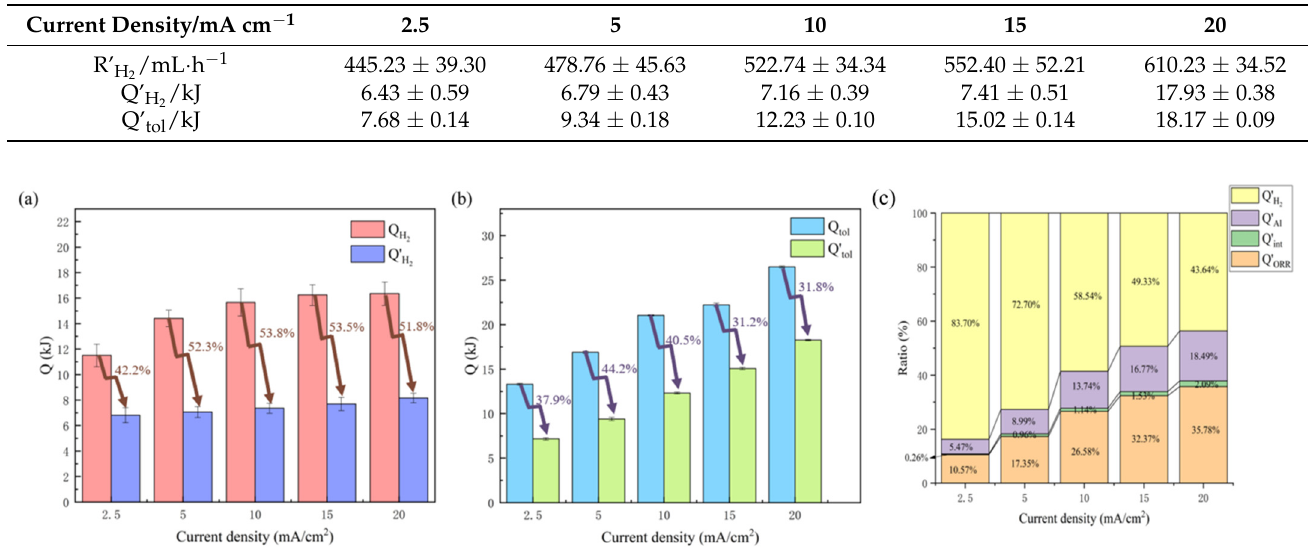
Table 4. The hydrogen-evolution reaction, the heat generated by the hydrogen-evolution reaction and total heat after regulating the hydrogen-evolution reaction.